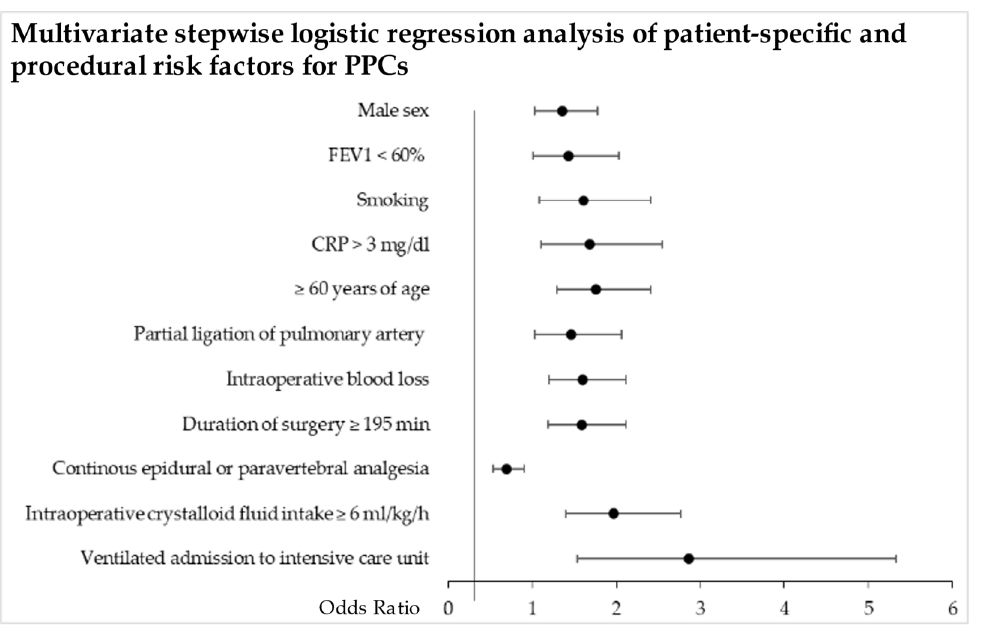
Figure 4. Multivariate stepwise logistic regression analysis of patient-specific and procedural risk factors for PPCs in primary lung cancer patients undergoing thoracotomy for lung resection. The OR and 95% CI are shown. CRP = C-reactive protein, FEV 1 = forced expiratory volume in 1 s. The surgical risk factors of duration of surgery ≥ 195 min (OR 1.6, 95% CI 1.2–2.1, p = 0.002), amount of intraoperative blood loss per 100 mL (OR 1.6, 95% CI 1.2–2.1, p =